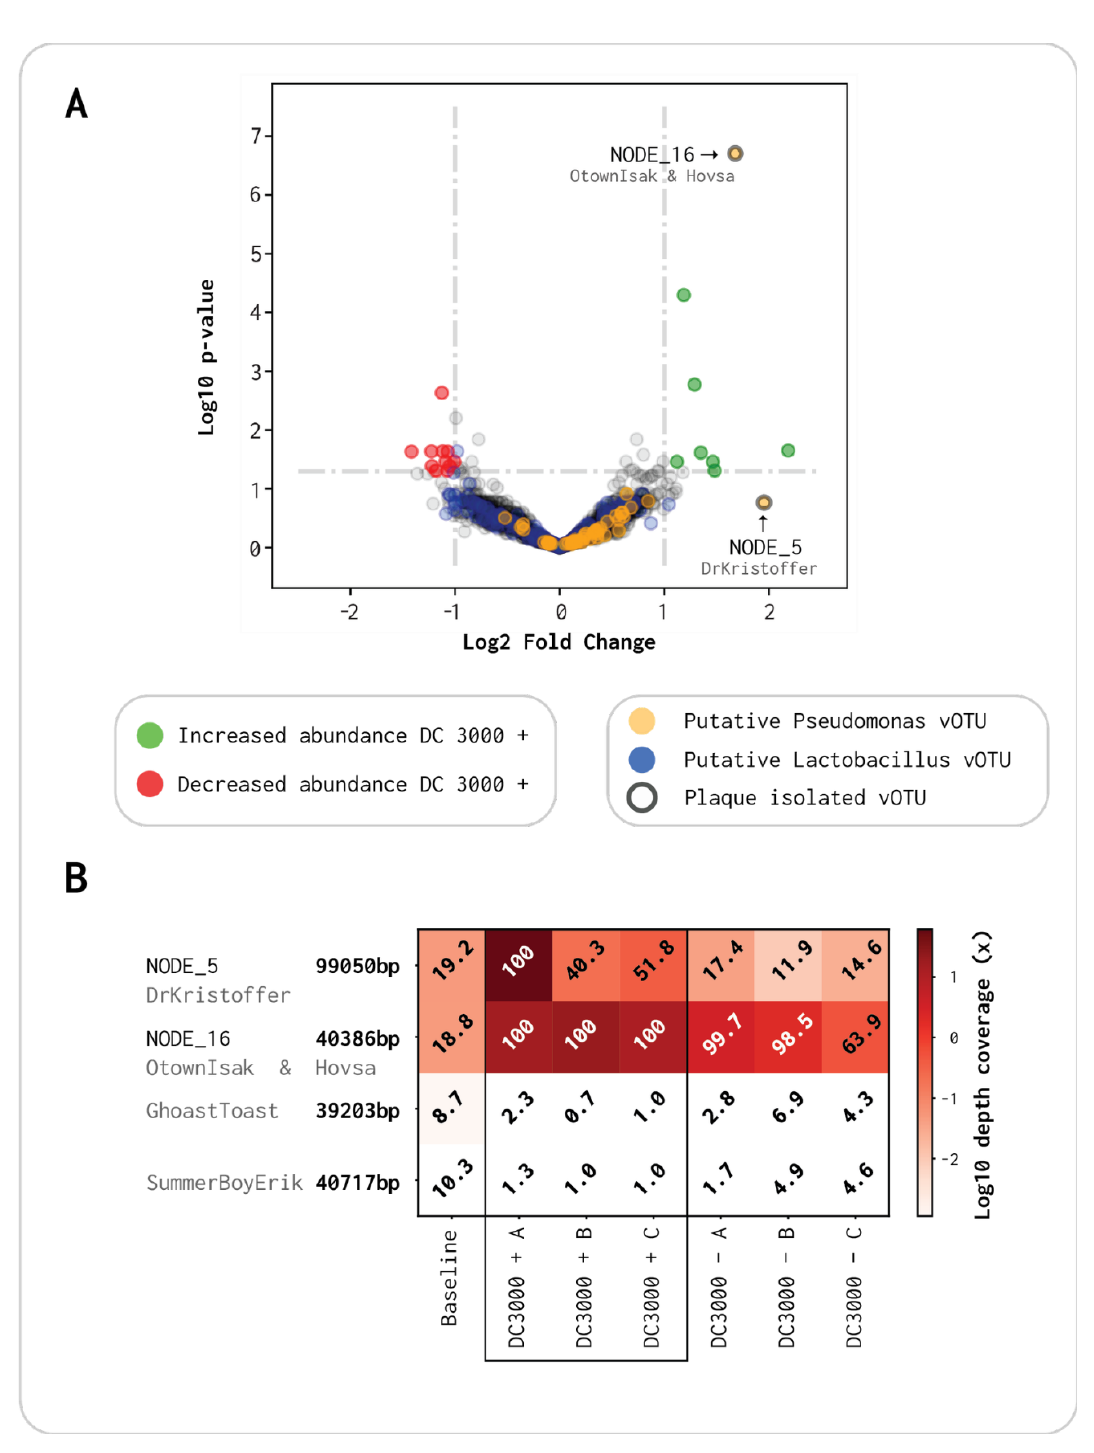
Figure 5. Volcano plot of abundance comparison between DC3000 + and DC3000 − : ( A ) the X -axis is the log 2 fold change (Log 2 FC) in read abundance between the two viromes, and the Y -axis is the log 10 p -value for read abundance in the triplicates. Ringed dots: plaque-forming phages; yellow dots : putative Pseudomonas phages; blue dots: putative Lactobacillus phages; green dots : viral contigs that increased by >1 Log 2 FC with a significant p -value; red dots: viral contigs that were reduced by < − 1 Log 2 FC with a significant p -value; ( B ) read abundance for the five plaque-forming phages throughout the seven viromes. White numbers indicate contigs with a breadth coverage ≥ 80%, which were presumed present, while black values indicate contigs with <80% breadth coverage, regarded as not present.